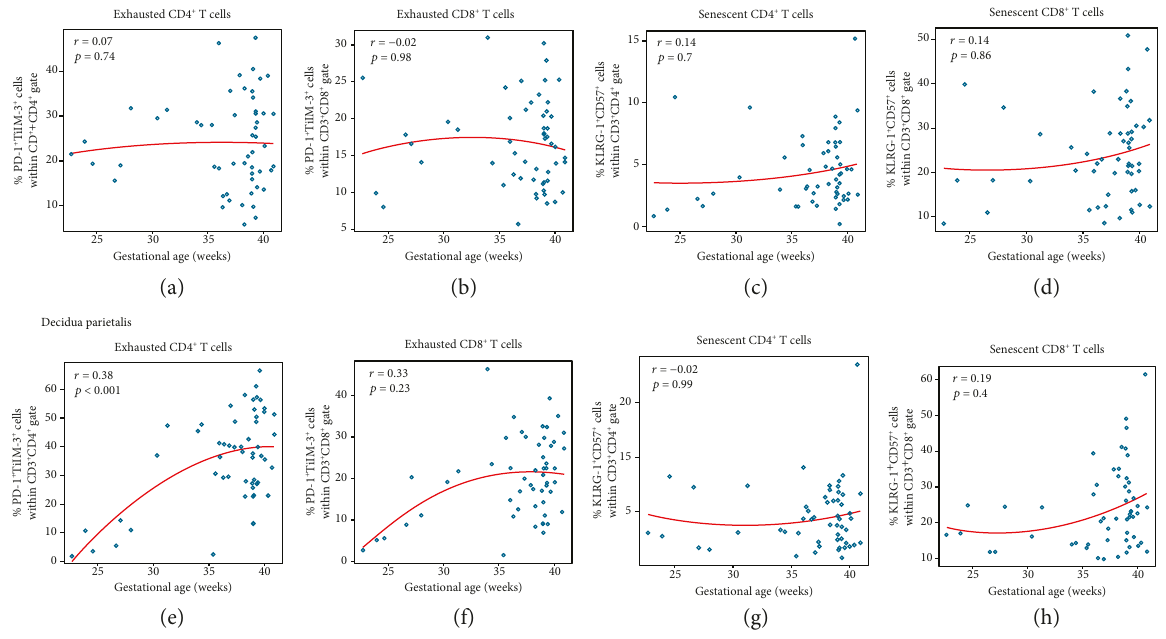
Figure 3: Correlations between exhausted or senescent CD4 + and CD8 + decidual T cells and gestational age. The correlations between gestational age and the proportions of exhausted or senescent CD4 + and CD8 + T cells in the decidua basalis (a – d) and decidua parietalis (e – h). The red line represents locally weighted scatter plot smoothing (LOESS) estimating the average cell percentages as a function of gestational age (weeks). The correlations were assessed using a Spearman ’ s correlation test. Correlation coe ffi cients and p values are shown for each